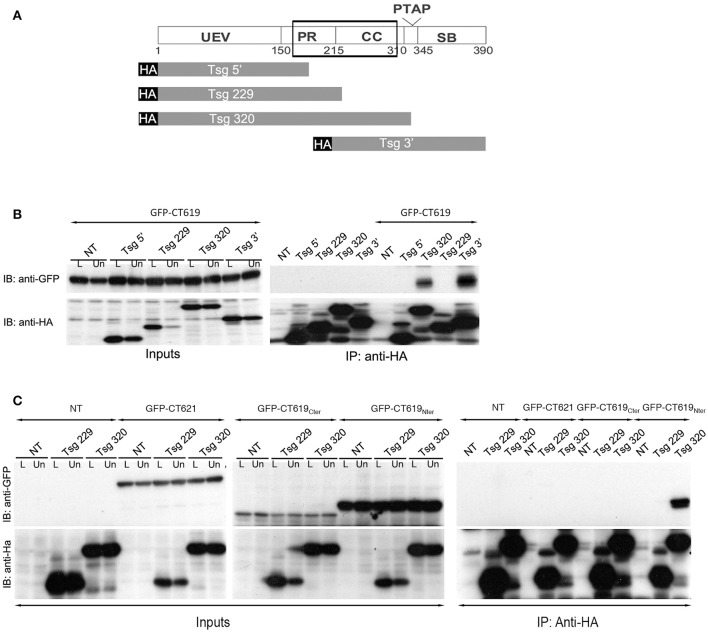
The ESCRT-I protein Tsg101 interacts with CT619. (A) Schematic view of the domains in Tsg101. The minimal region of interaction with CT619 identified in the two-hybrid screen is boxed. The four HA-tagged constructs used are schematized below. (B) HEK-293 cells were transfected with HA-tagged Tsg101 constructs alone or together with GFP-CT619 for 24 h, lysed and immunoprecipitated with anti-HA antibody coupled to agarose beads. Proteins were separated on SDS-PAGE, transferred on a PVDF membrane and probed with anti-GFP antibody. An aliquot of each cell lysate before (L) of after the immunoprecipitation (Un for Unbound) was loaded on a separate gel to compare the expression level of each of the proteins (Input, left, only shown for the co-transfections). IB, immunoblot; IP, immunoprecipitation. GFP-CT619 co-immunoprecipitated with the constructs Tsg320 and Tsg3', which include the coiled-coil domain of Tsg101. (C) Same as in B, with co-expression of HA-tagged Tsg101 constructs together with GFP-CT621, the DUF582 of CT619 (GFP–CT619Cter), or with its N-terminal domain (GFP-CT619Nter). Only the latter interacts with the Tsg320 construct.